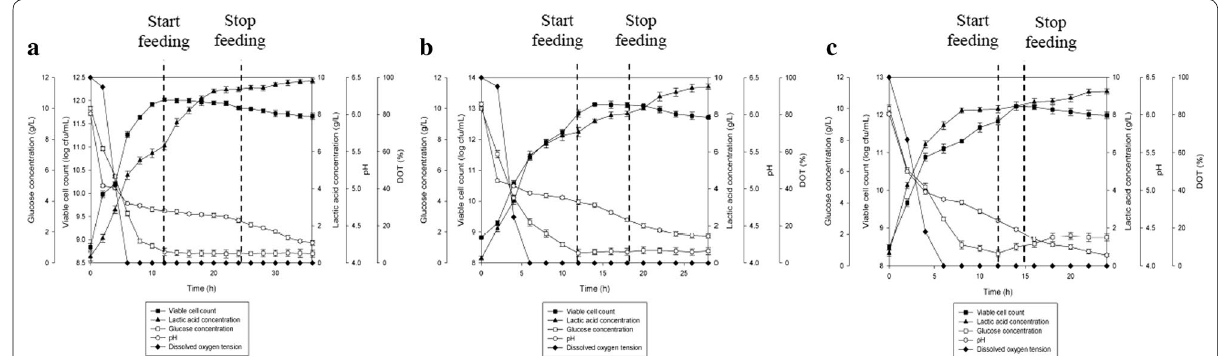
Fig. 5 The time course of constant fed-batch fermentation of P. acidilactici in 2 L stirred tank bioreactor at feeding rate of a 0.008 L/h, b 0.015 L/h and c 0.03 L/h. The error bars represent the standard deviations about the mean (n